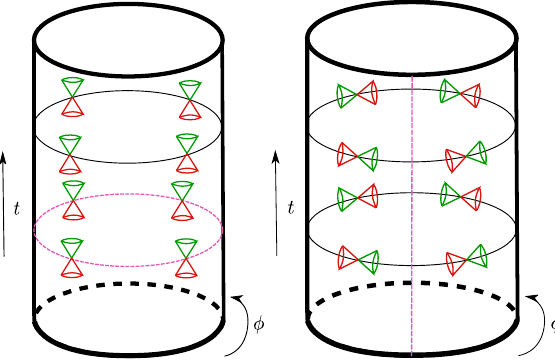
Fig. 8 The cylinder endowed with a flat metric allows two alternative perspectives regarding the causal description of the spacetime: a space- like ring evolving in time or as a line configuration evolving in time periodically. The two alternatives are differentiated just by the choice of what we call time and what we call space. We have marked on dot- ted pink line the putative surfaces on which we would put initial data according to our choice of time and space